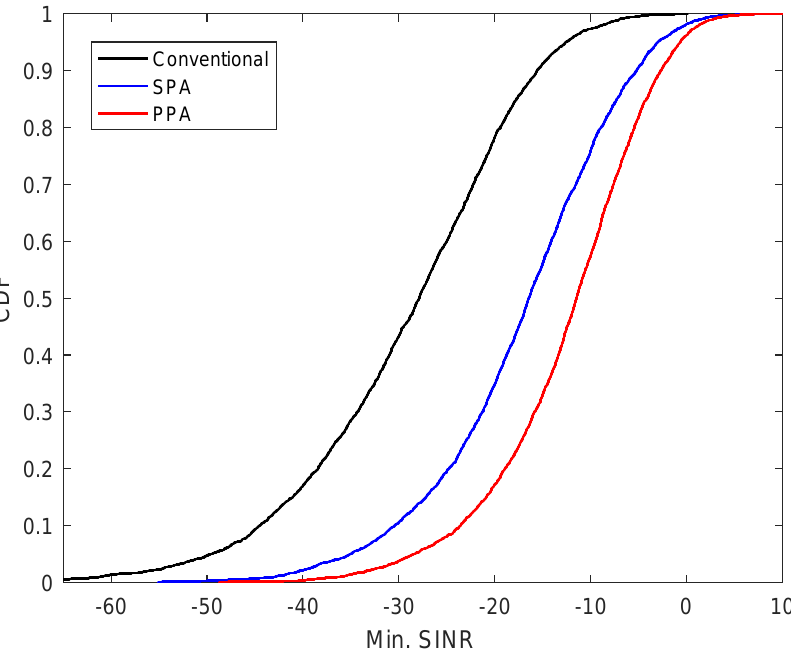
Figure 5. CDF of the minimum SINR per user when M = 64 using a ZF